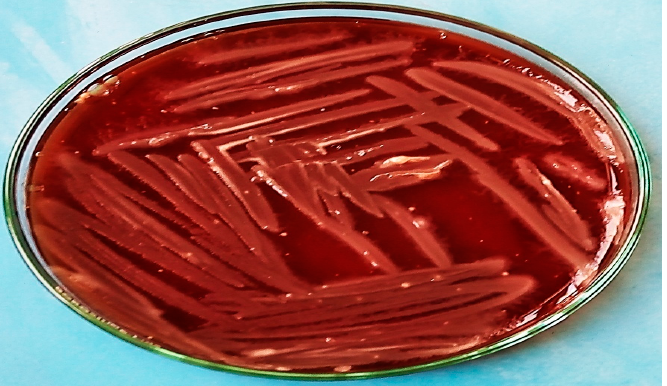
Figure 1. Blood agar media inoculated with C. botulinum showing a narrow zone of β -hemolysis surrounding the colonies.